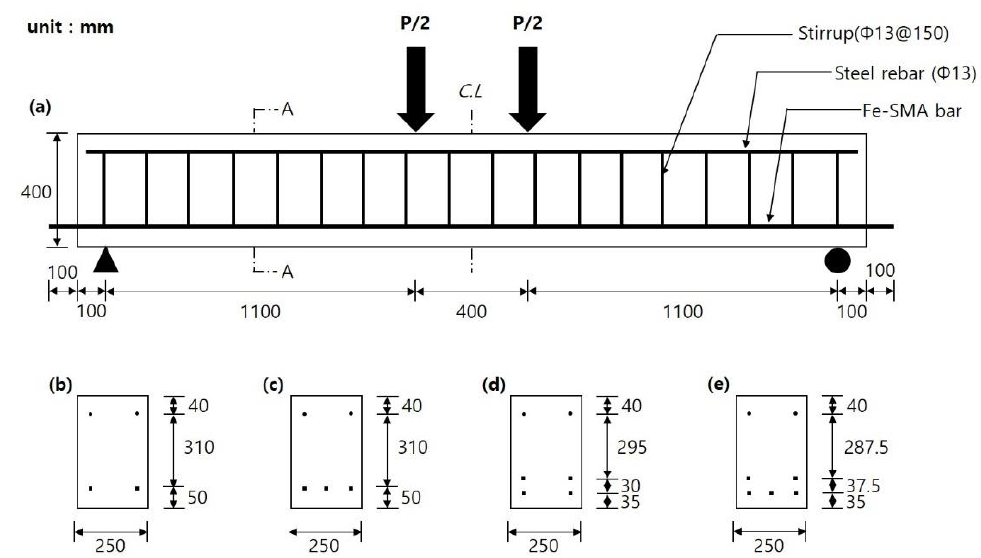
Figure 1. Details of test specimens [31]. ( a ) Schematic of test specimens. ( b ) With 2 SMA bars. ( c ) With 3 SMA bars. ( d ) With 4 SMA bars. ( e ) With 5 SMA bar.